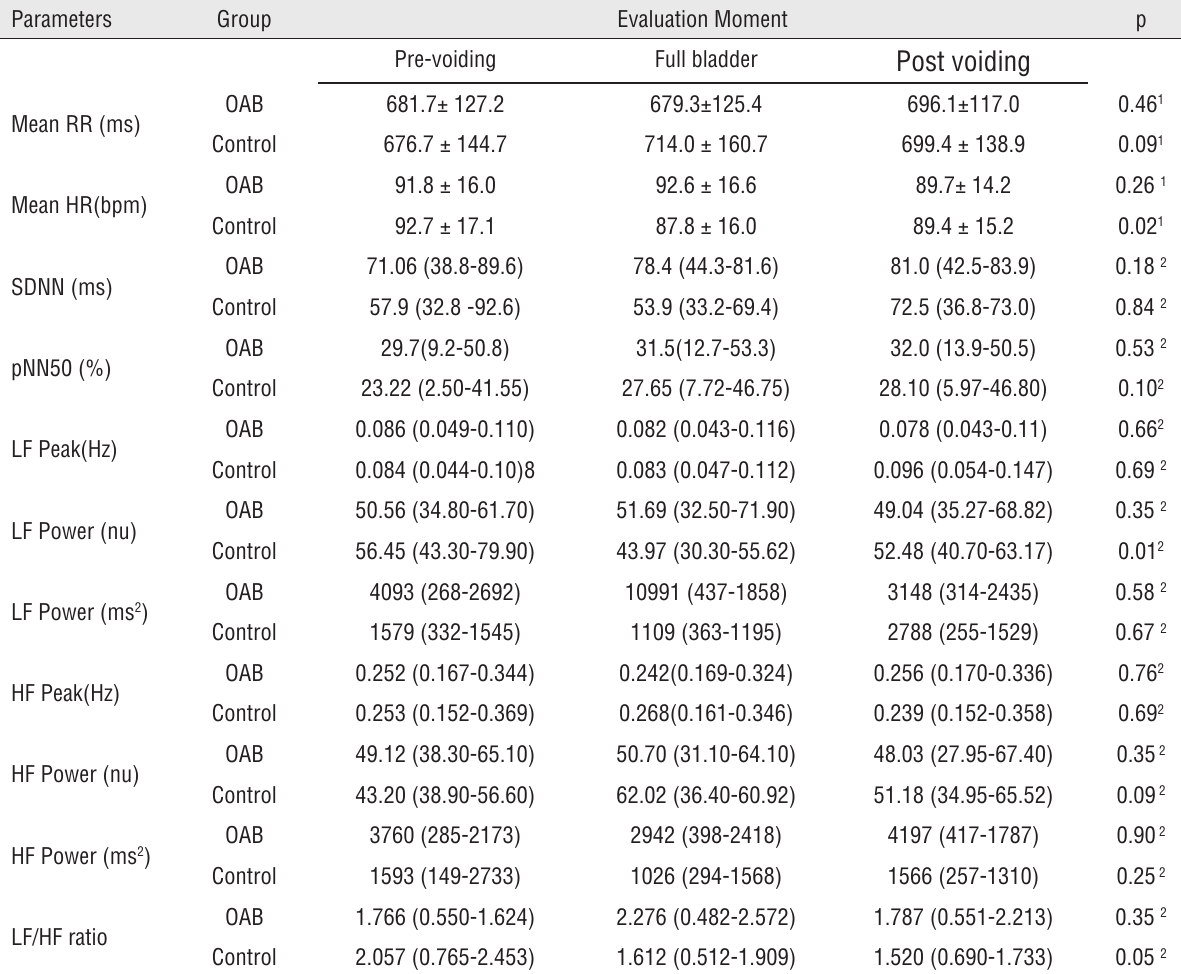
Table 3 - Heart rate variability within the overactive bladder (OAB) and control groups at three evaluation moments: intragroup